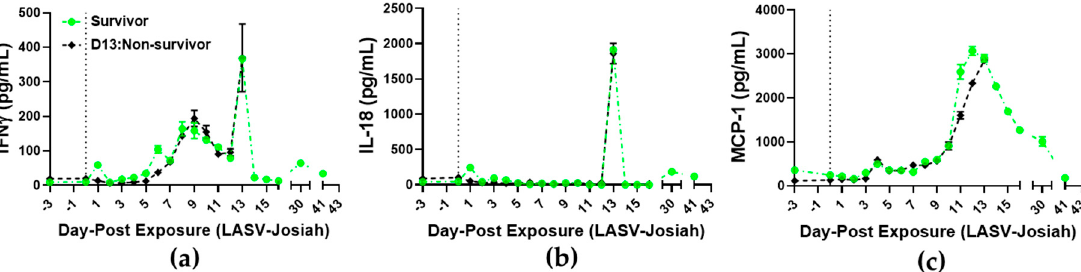
Figure 7. Analysis of immune responses in blood from aerosol LASV-infected cynomolgus macaques. Cytokine analyses of blood, ( a ) IFN γ , ( b ) IL-18, and ( c ) MCP-1, were performed on samples collected 3 days prior to exposure and DPE 0–41. ( ● Survivor) ( ♦